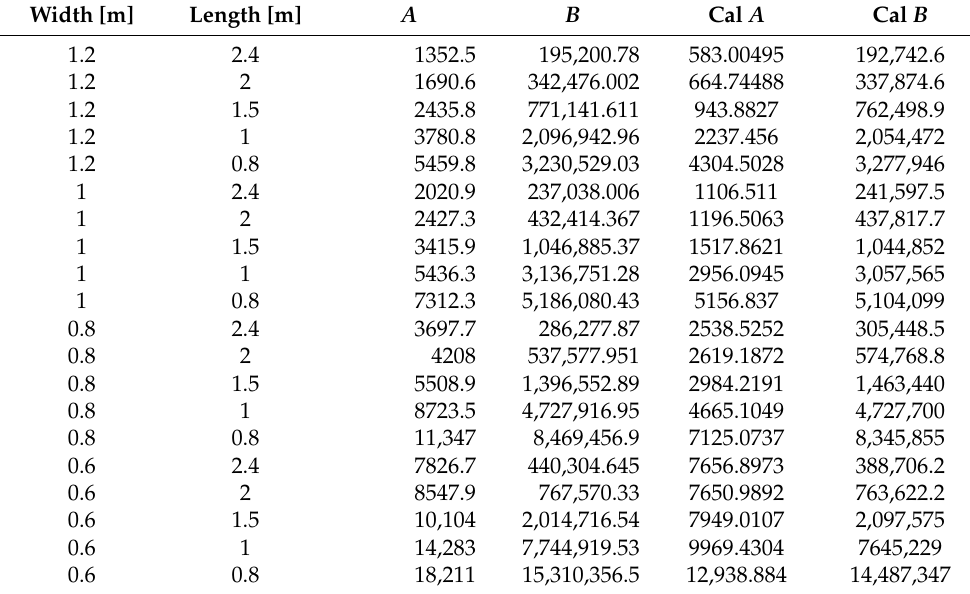
Table A9. The 6 mm plate FEA A , B and theory calculated A , B .